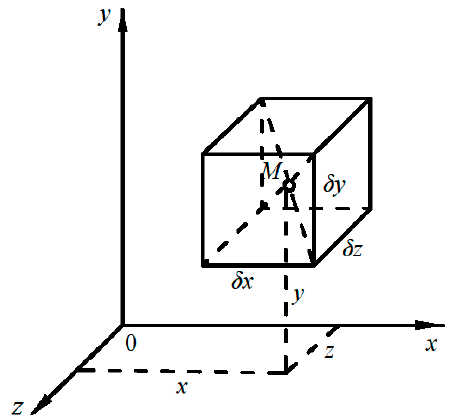
Figure A3. Schematic diagram of a regular hexahedron element. The control volume is a regular hexahedron element δ x δ y δ z with centroid M and coordinates ( x , y , z ） .